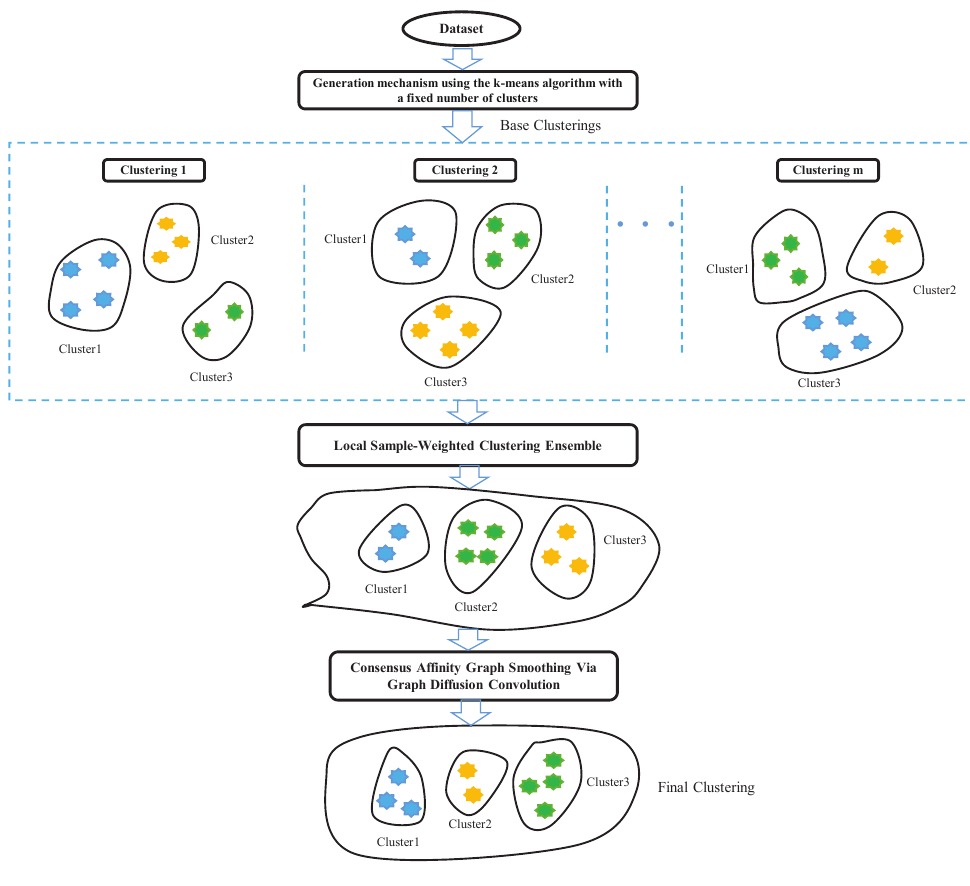
Figure 1. Schematic diagram of the algorithm